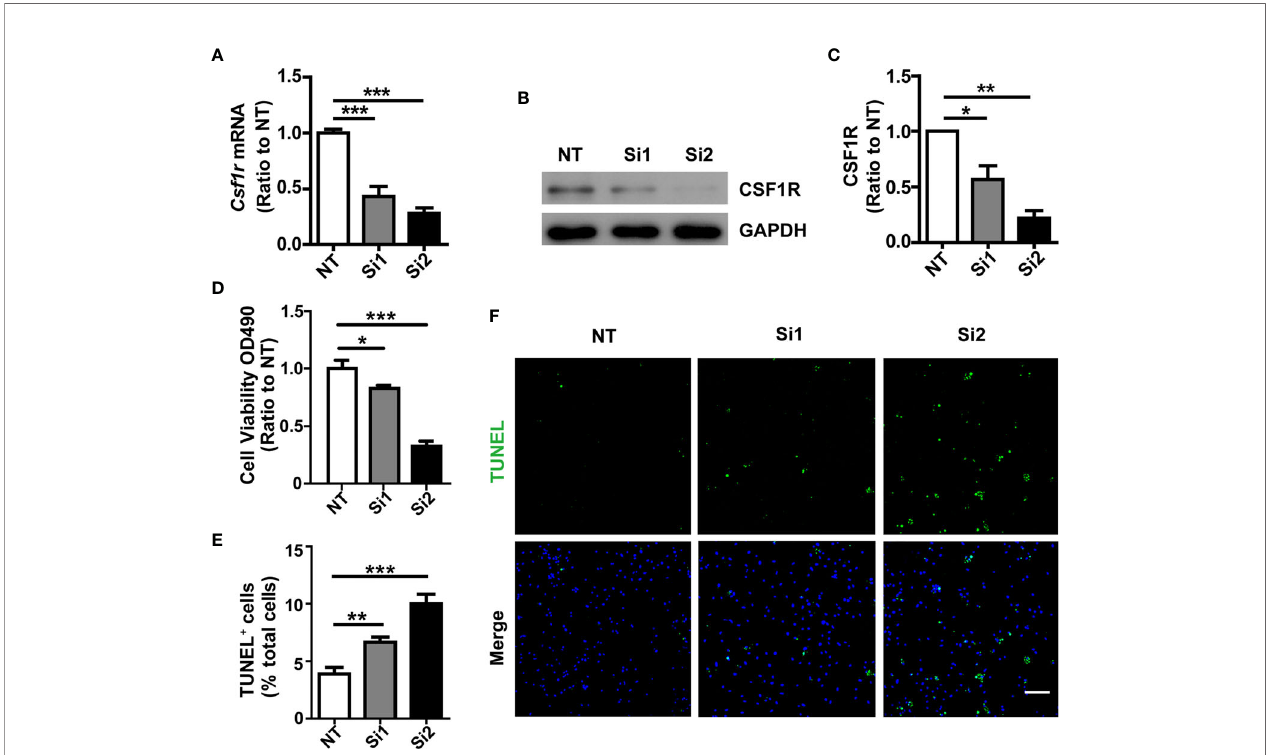
FIGURE 3 | Decreased cell survival in Csf1r knockdown microglia. (A) Csf1r was knocked down in primary microglia by two independent siRNAs and the knockdown ef fi ciency was assessed by qRT-PCR. (B, C) Csf1r knockdown ef fi ciency was assessed by Western blotting. (D) Knockdown of Csf1r suppressed microglial viability as examined by MTS assay. (E, F) The apoptosis and necrosis of Csf1r knockdown microglia were assessed by TUNEL staining. TUNEL-positive cells (green) that co-localized with DAPI were quanti fi ed as a percentage of total DAPI-positive cells (blue). The number of TUNEL-positive cells that co-localized with DAPI increased in Csf1r knockdown microglia compared with nontarget control (NT). Scale bar, 50 µm. Two-way ANOVA with Tukey ’ s multiple comparison test. Data are plotted as mean ± SEM (n=3). * p <0.05; ** p <0.01; *** p